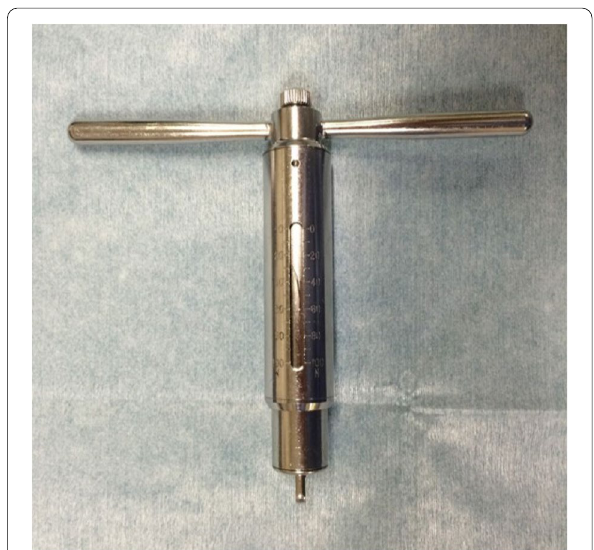
Fig. 1 The tension meter (Ligament tensioner 3, MEIRA Corporation, Nagoya,